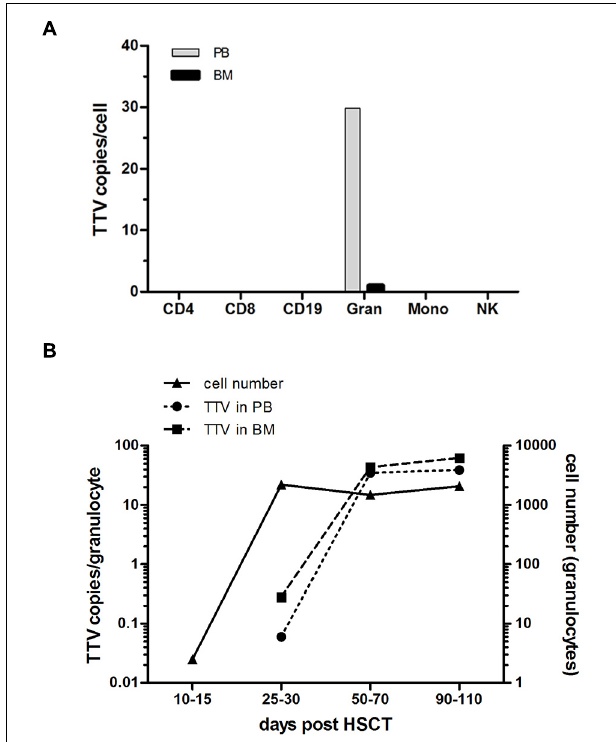
FIGURE 3 | TTV detection in leukocyte subsets and virus replication kinetics after transplantation. Leukocyte subsets including CD4 + , CD8 + , CD19 + , CD15 + (granulocytes: Gran), CD33 + (monocytes: Mono) and CD56 + (natural killer cells: NK) were isolated by flow sorting from peripheral blood (PB) and bone marrow (BM) of 19 pediatric HSCT recipients. Individual cell subsets were tested for the presence and quantity of virus copies by a TTV-specific RQ-PCR assay. (A) The median of the peak TTV copy numbers per cell determined in the patients investigated is shown for the different leukocytes subsets. (B) The TTV replication kinetics in granulocytes isolated from PB and BM of the 19 patients investigated is shown by the median virus copy numbers per cell at the indicated time points post-HSCT. The y -axis on the right side indicates the granulocyte numbers per µ l